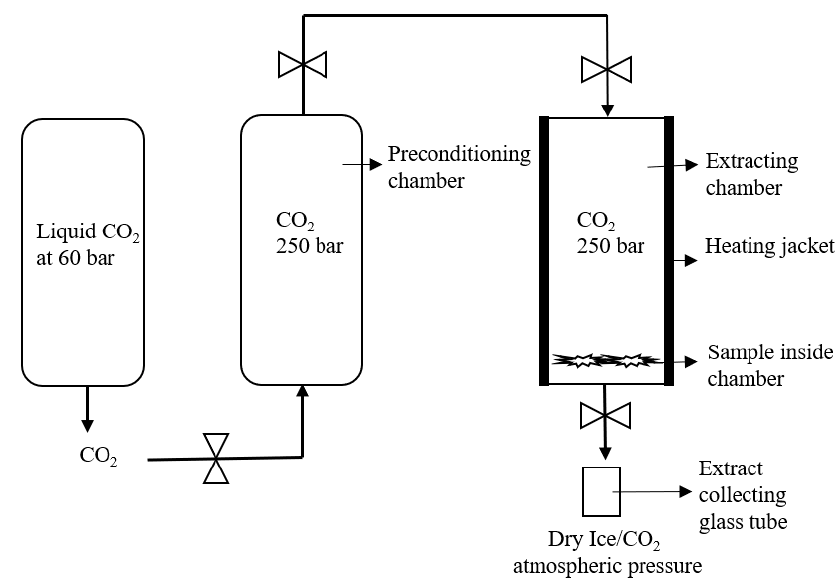
Figure 3. Schematic representation of the Helix unit for setup E extraction.